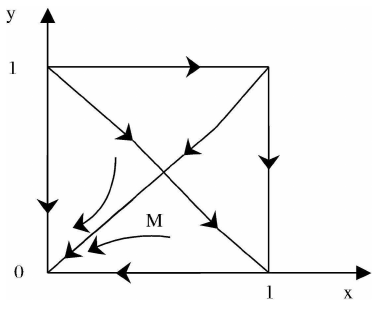
Fig. 4 Evolutionary phase diagram